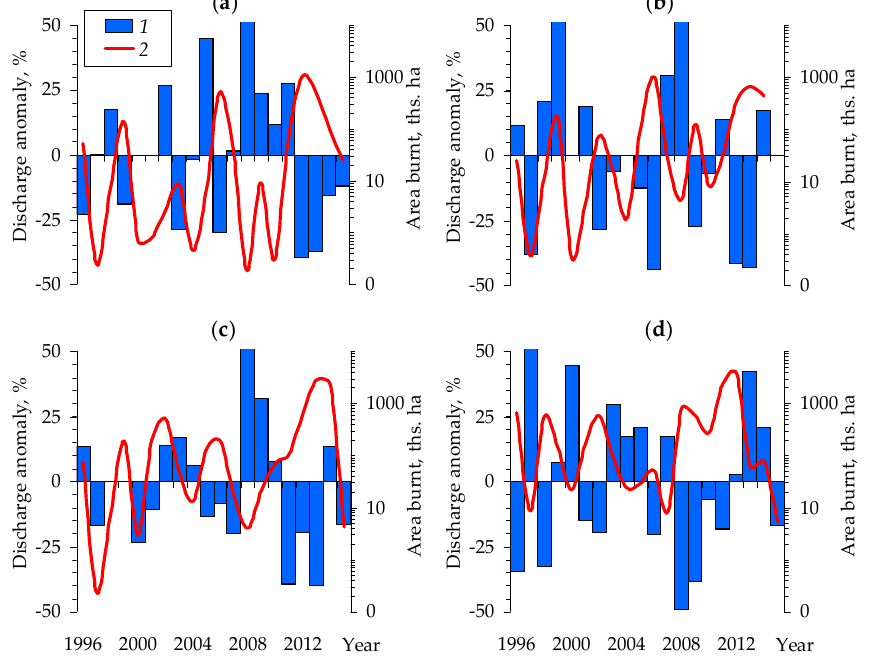
Figure 3. The seasonal variety of discharge anomalies (1) and burnt area (2) for 1996–2015. The river basins are: ( a ) Podkamennaya Tunguska; ( b ) Lower Tunguska; ( c ) Viluy; and ( d )